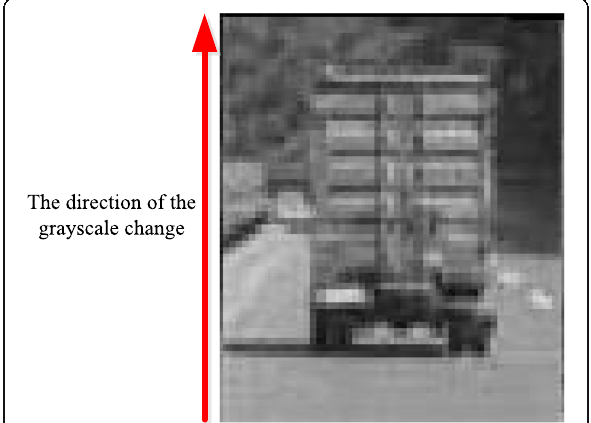
Fig. 8 Schematic diagram of the change of the road image